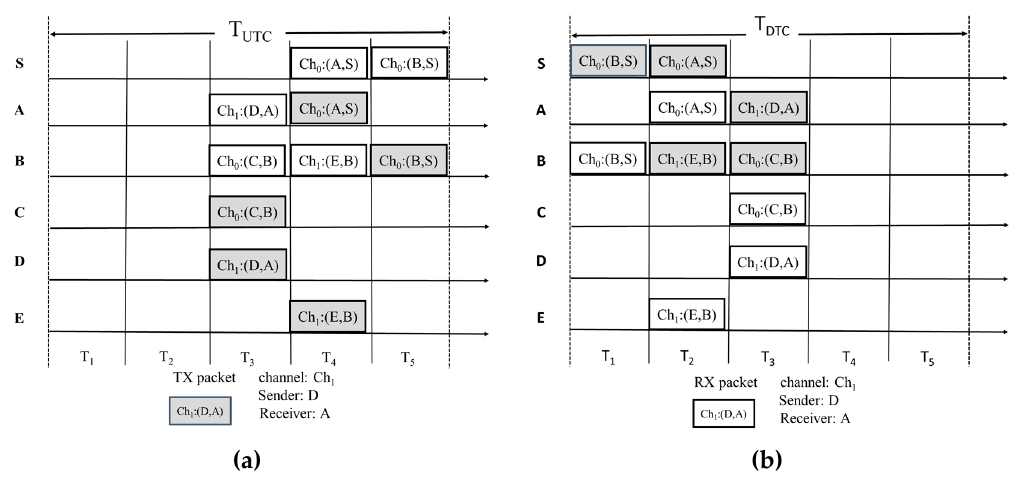
Figure 9. Data transmission before receiving the REDUCE command packet. ( a ) Data transmission in the UTC; ( b ) Data transmission in the DTC.